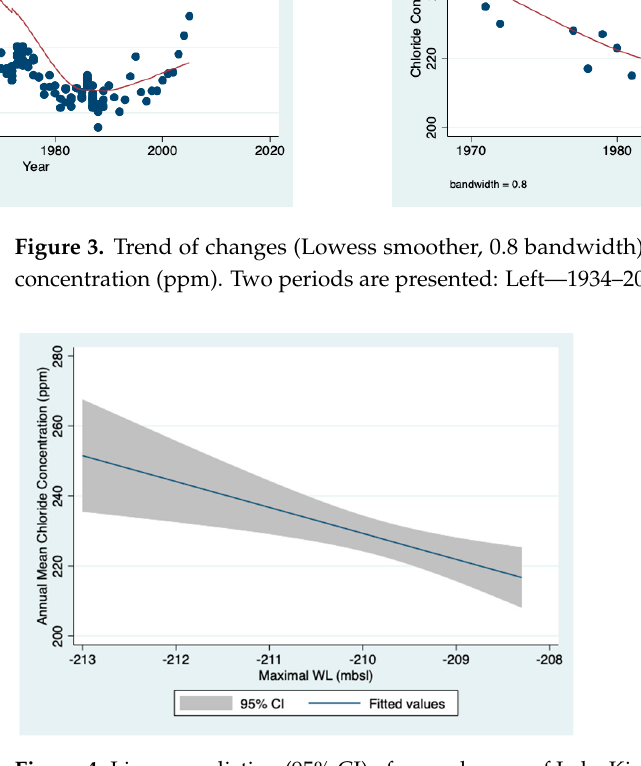
Figure 4. Linear prediction (95% CI) of annual mean of Lake Kinneret’s chloride concentration (ppm) relative to the annual mean of Lake Kinneret’s WL altitude (mbsl) (1969–2018).